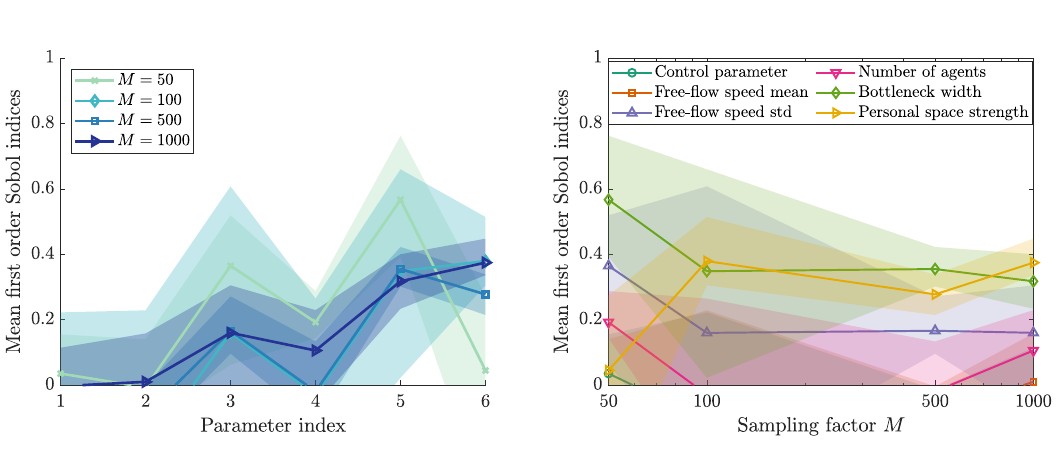
Figure A3. First order Sobol’ indices for the new range of the personal space strength parameter. The parameter index is mapped as follows: 1—control parameter, 2—free-flow speed mean, 3—free-flow speed standard deviation, 4—number of agents, 5—bottleneck width, 6—personal space strength.